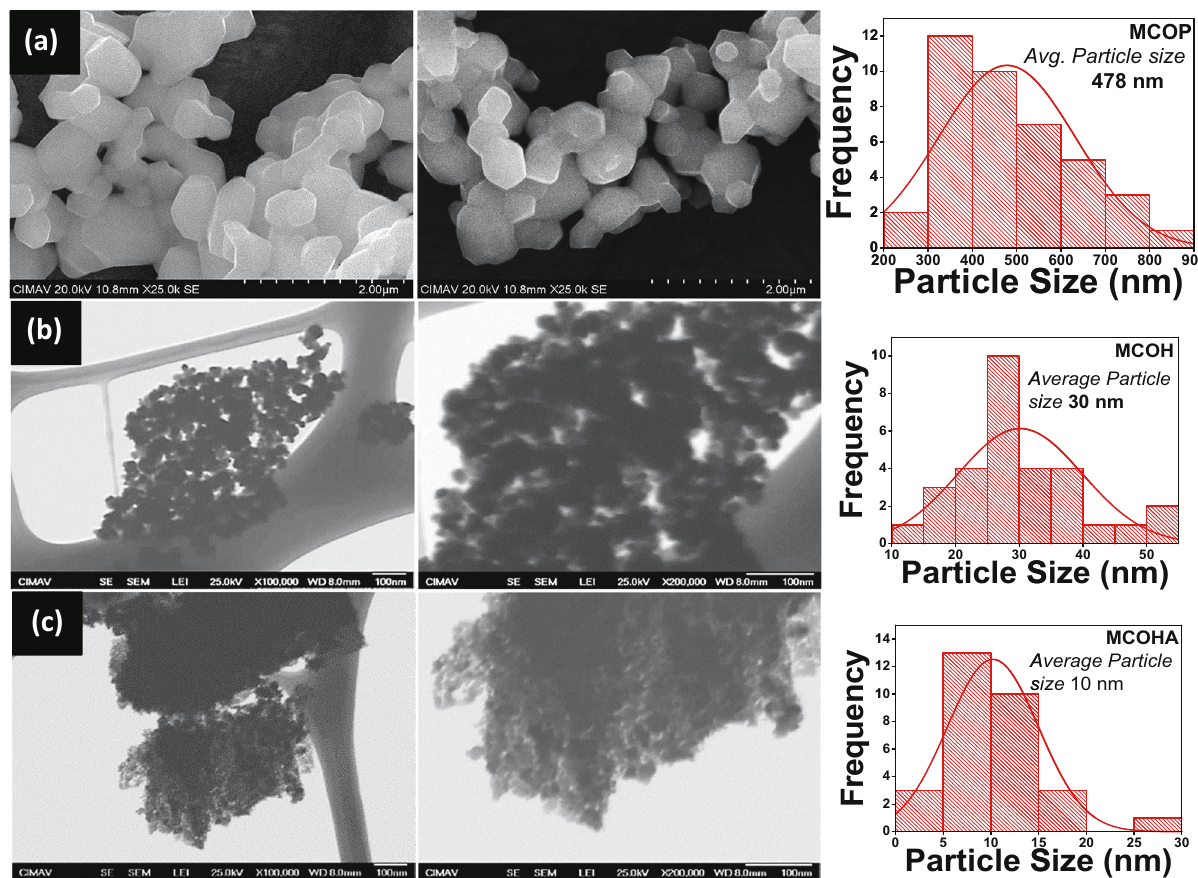
Figure 5: STEM images of the MCO synthetized by di ff erent methods: ( a ) pechini at 900°C, ( b ) hydrothermal with NaOH at 500°C, and ( c ) hydrothermal with acetates at